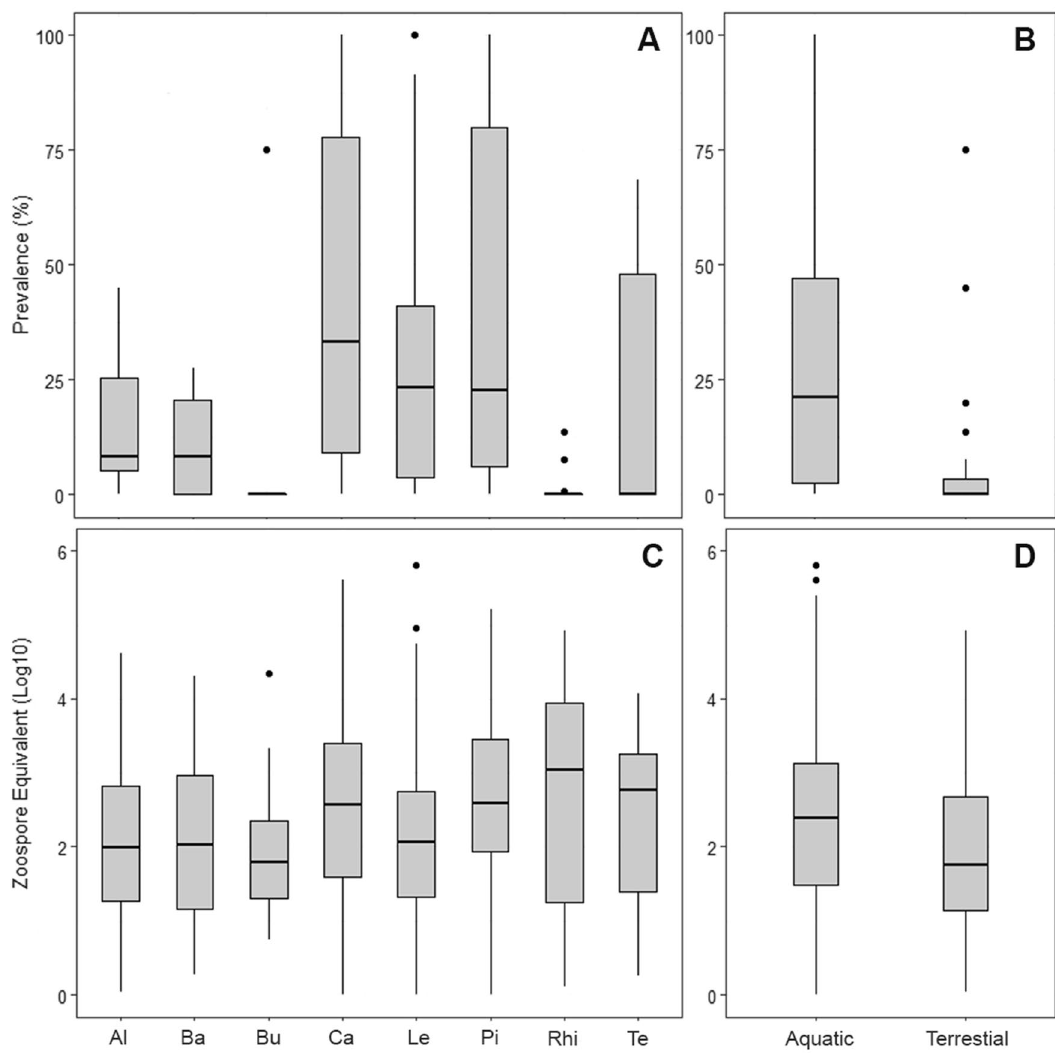
Figure 2. Boxplots showing Batrachochytrium dendrobatidis (Bd) prevalence (%) by ( A ) anuran family and ( B ) host ecology (aquatic vs. terrestrial), and Bd zoospore equivalent (Log 10 ) by ( C ) anuran family and ( D ) host ecology, for amphibians in Chile collected from 2008 to 2018. Anuran family abbreviation: Al (Alsodidae), Ba (Batrachylidae), Bu (Bufonidae), Ca (Calyptocephalellidae), Le (Leptodactylidae), Pi (Pipidae), Rhi (Rhinodermatidae) and Te (Telmatobiidae). The centre line in each box indicates the median, the upper and lower box sides represent the interquartile range, the whiskers extend to the 5th and 95th percentiles and dots represent